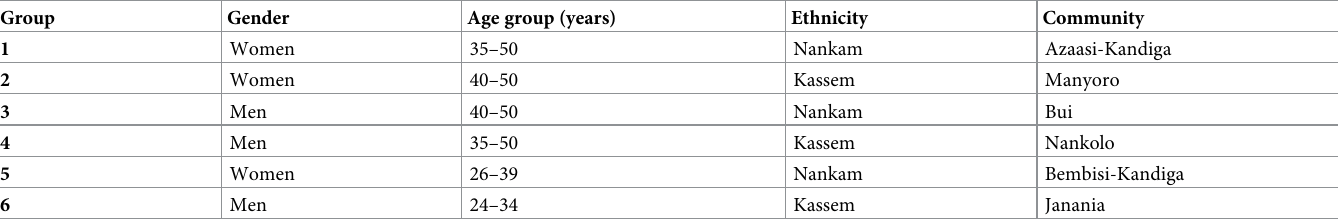
Table 1. Summary of community groups and study